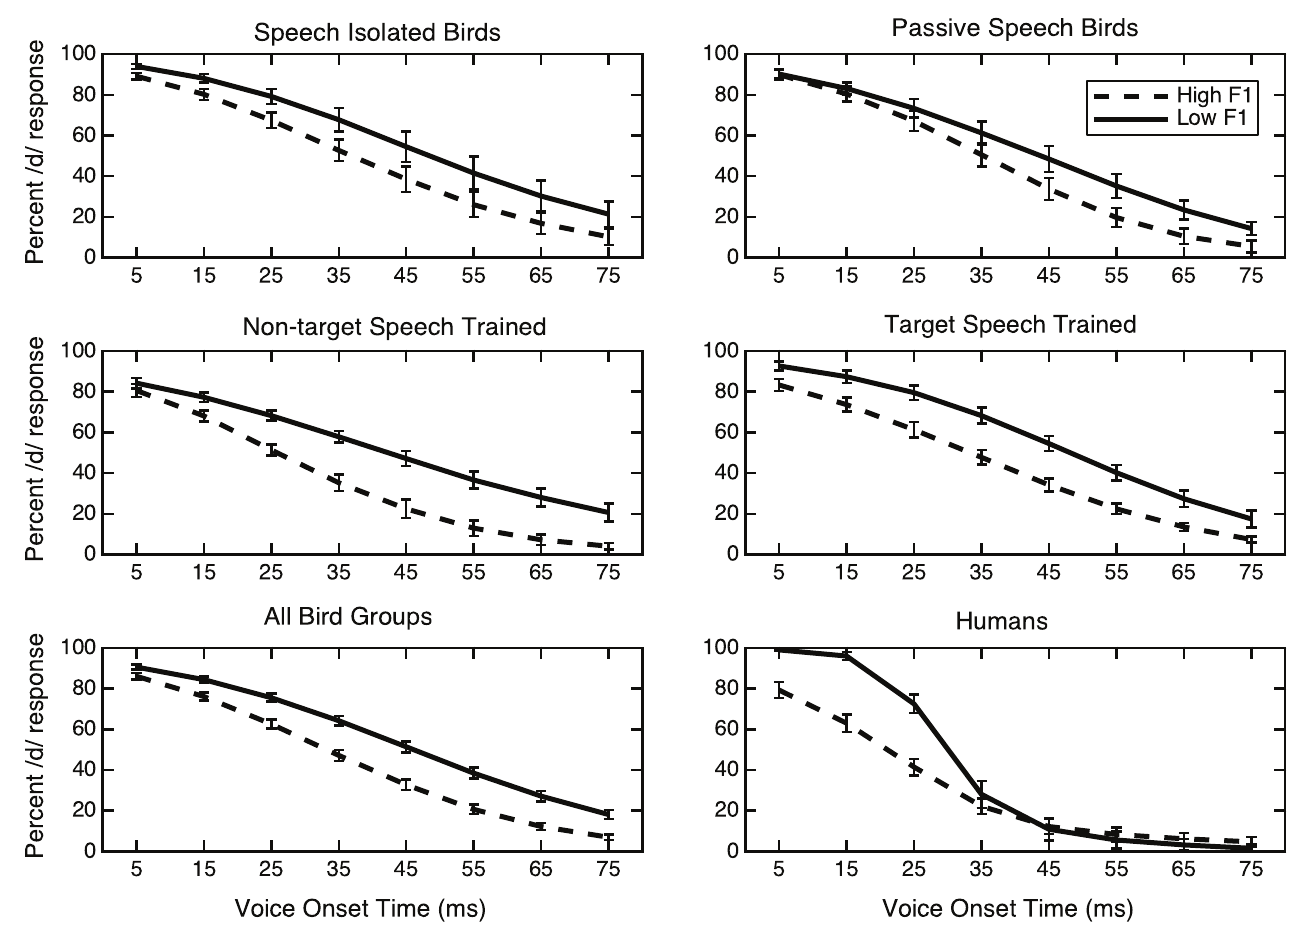
Fig 3. Fitted identification functions showing percentage of /d/ responses for birds and humans across various VOTs. The solid lines represent the responses to the low F1 stimuli, the dashed lines represent responses to the high F1 stimuli. Error bars represent ± 1 standard error of the mean.